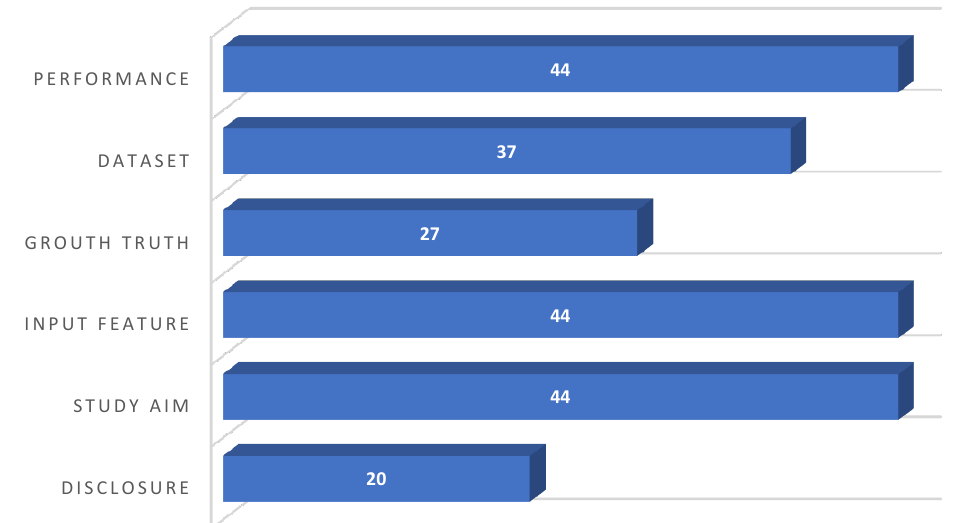
Figure 2. Quality assessment outcomes using the MINORS tool.